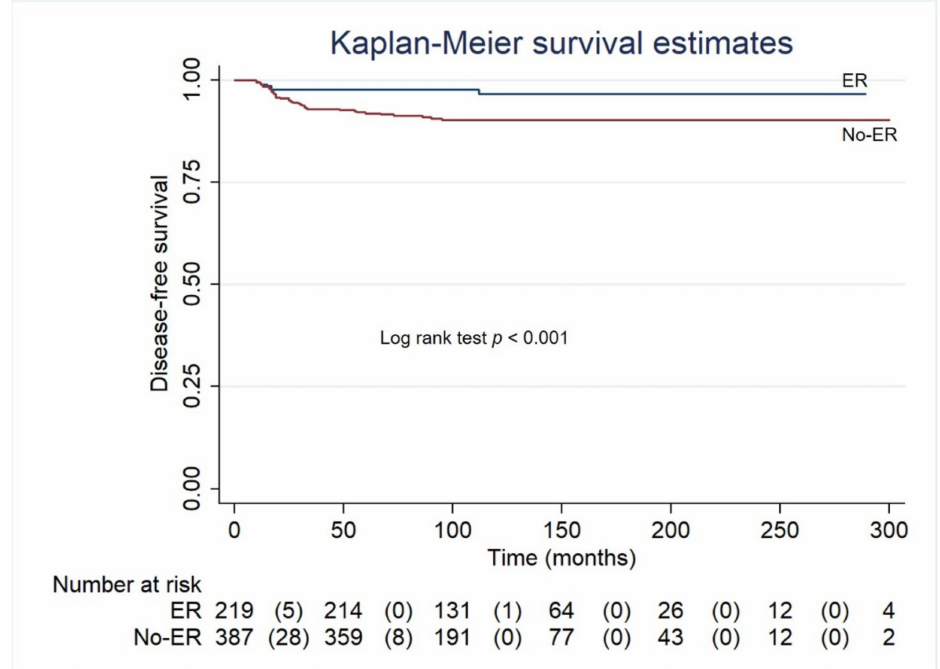
Figure 2. Disease-free survival by Kaplan-Meier in patients with ER and with no-ER at 12 months after RAI therapy. ER (excellent